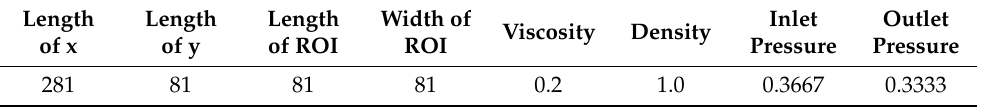
Table 2. The modeling parameters and grid size/grid resolution of LBM simulations.